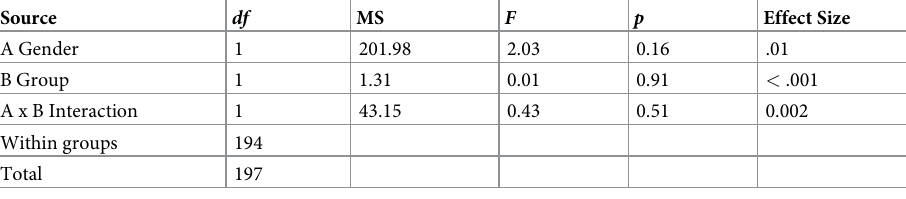
Note .—MS = Mean squares, effect size = partial η 2